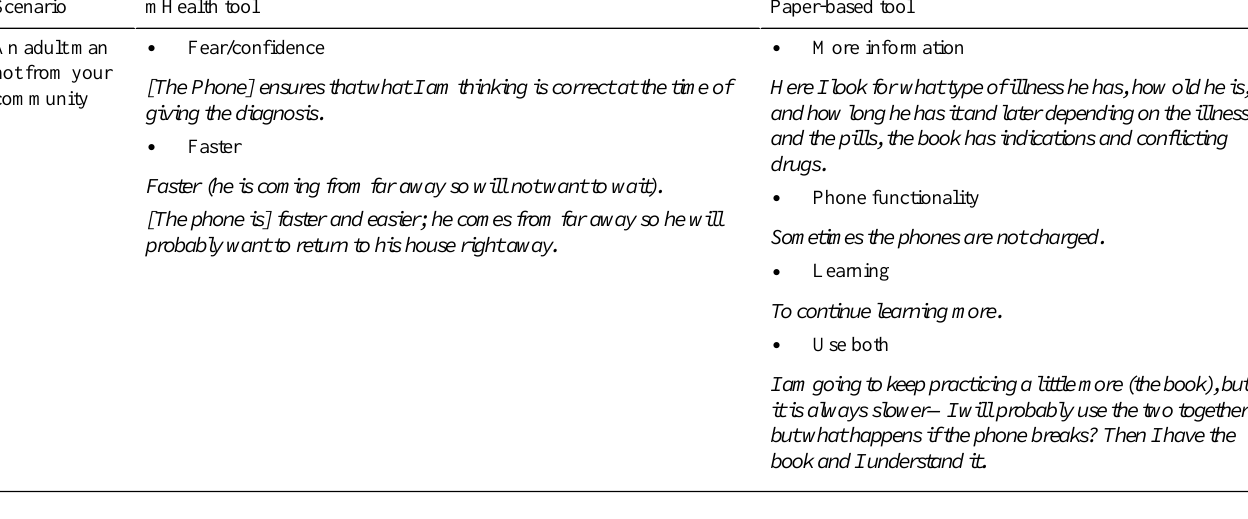
Figure 4. Tool preference, by potential patient demographic.